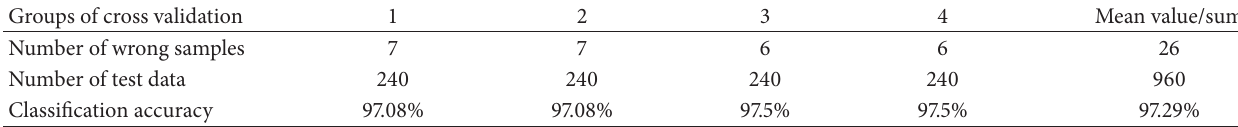
Table 5: The result of fault diagnosis for bearing under variable